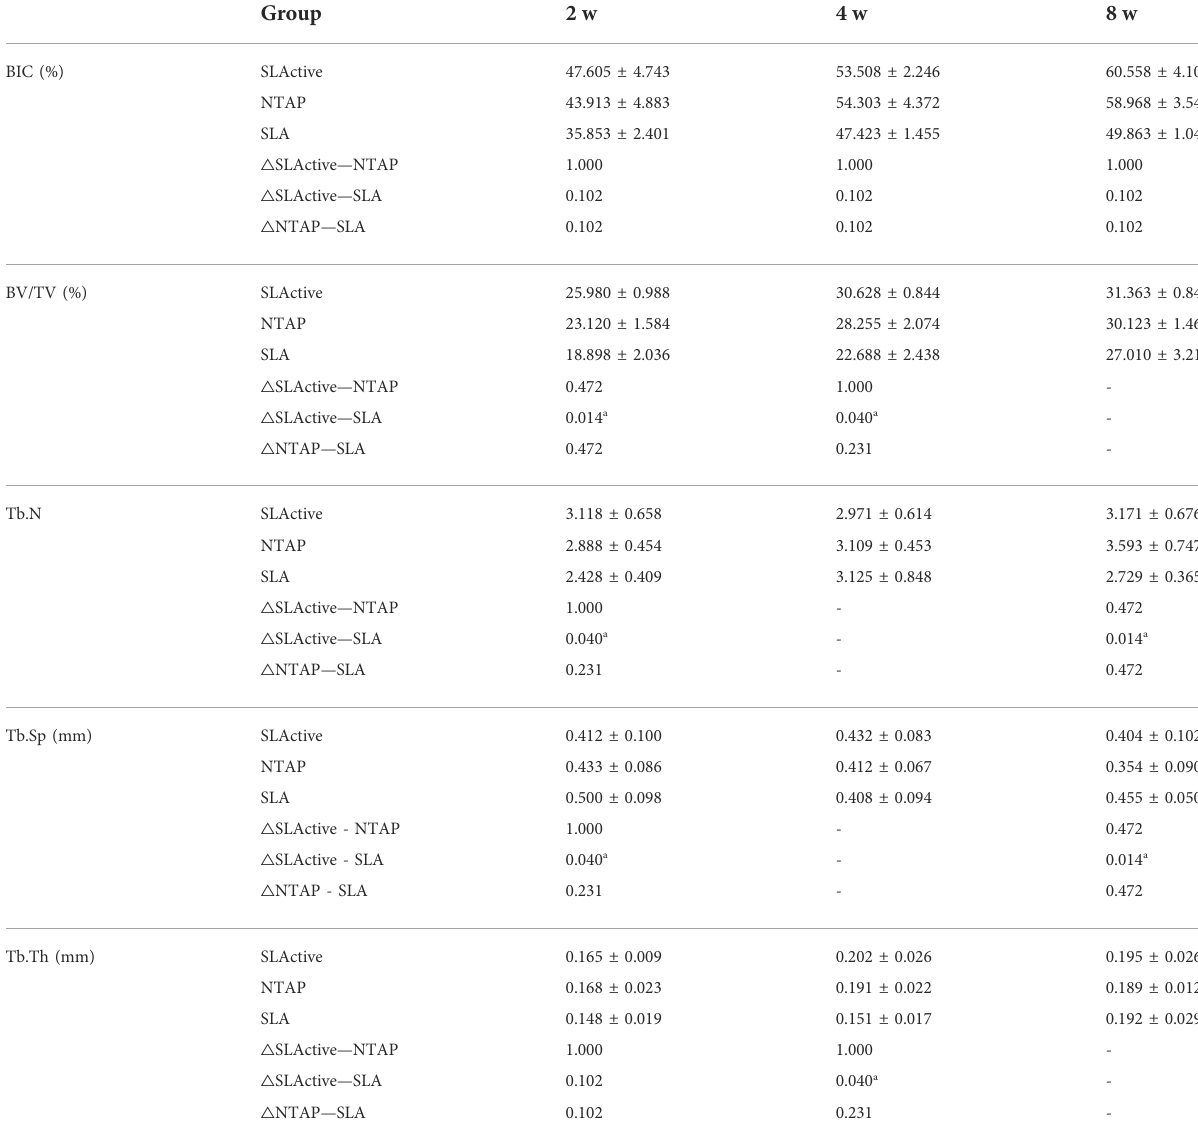
TABLE 1Micro-CTradiographicBIC %,BV/TV value,Tb.N,Tb.Sp, andTb.Th in thefourmiddlemmofthe implantsurfacesin different groups: 2-week healing, 4-week healing, and 8-week healing in both implant